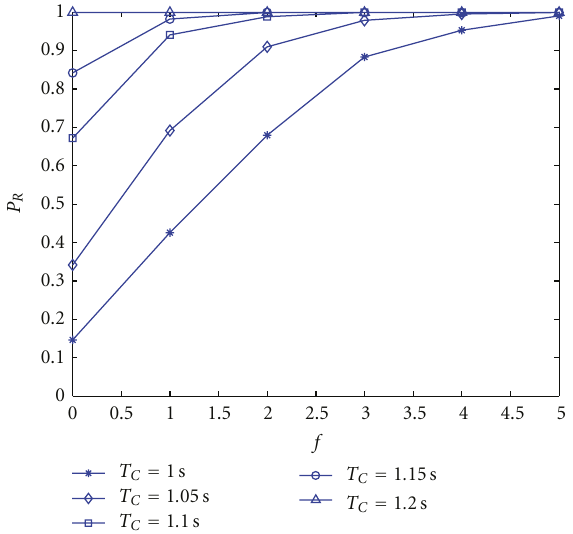
Figure 13: P R versus f when P DC = 1/16 and T A MAX = 37.5 ms, for di ff erent values of T C